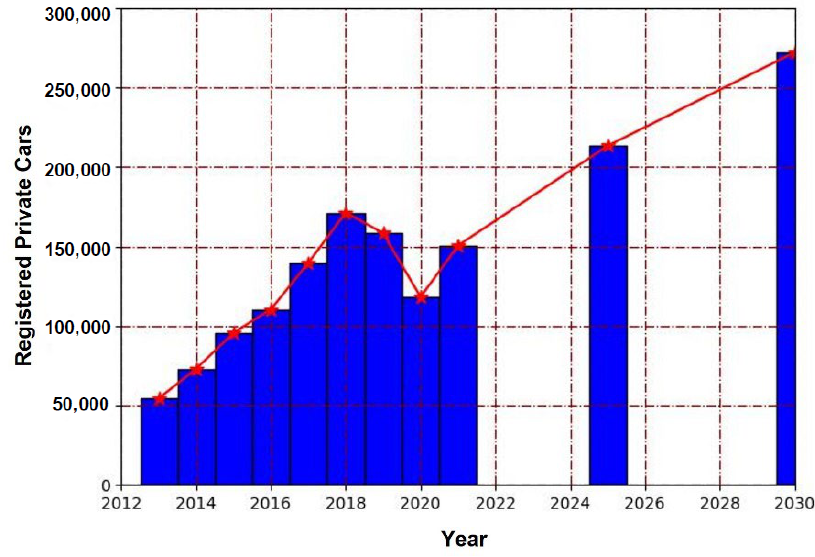
Figure 9. Statistics of registered private cars in Dhaka.